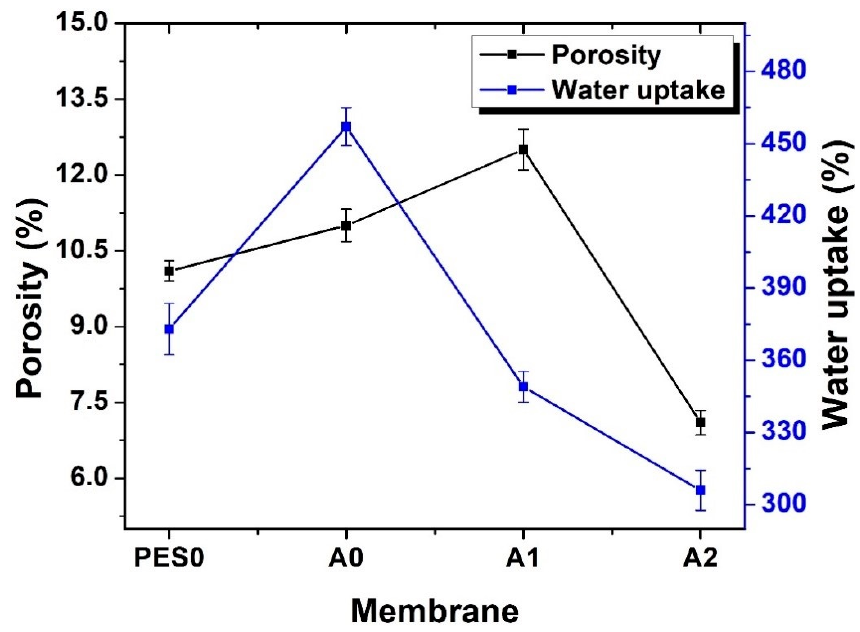
Figure 7. Water uptake and porosity of the fabricated membranes.